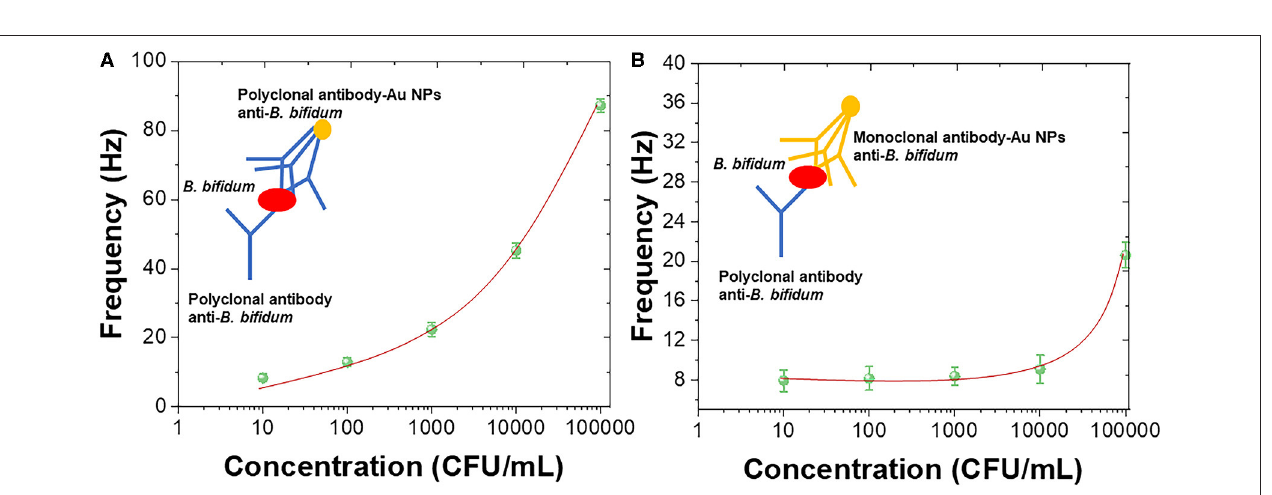
FIGURE 5 | Frequency vs. concentrations of B. bifidum using (A) polyclonal antibody-AuNPs conjugation and (B) mouse monoclonal antibody-AuNPs conjugation as the detection